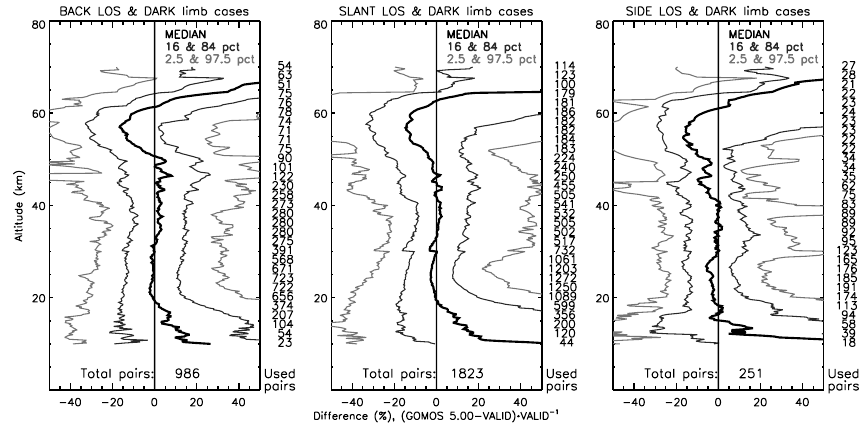
Fig. 7. As Fig. 4, except showing the cases grouped by line of sight azimuth angles. Left panel: backward viewing ( − 10 ◦ to 10 ◦ ); middle panel: slant viewing (10 ◦ to 45 ◦ ); right panel: sideward viewing (45 ◦ to 90 ◦ ). Figure 7: As Figure 4, except showing the cases grouped by line of sight azimuth angles. Left 3 panel: backward viewing (-10° to 10°); middle panel: slant viewing (10° to 45°); right panel: 4 sideward viewing (45° to 90°). 5